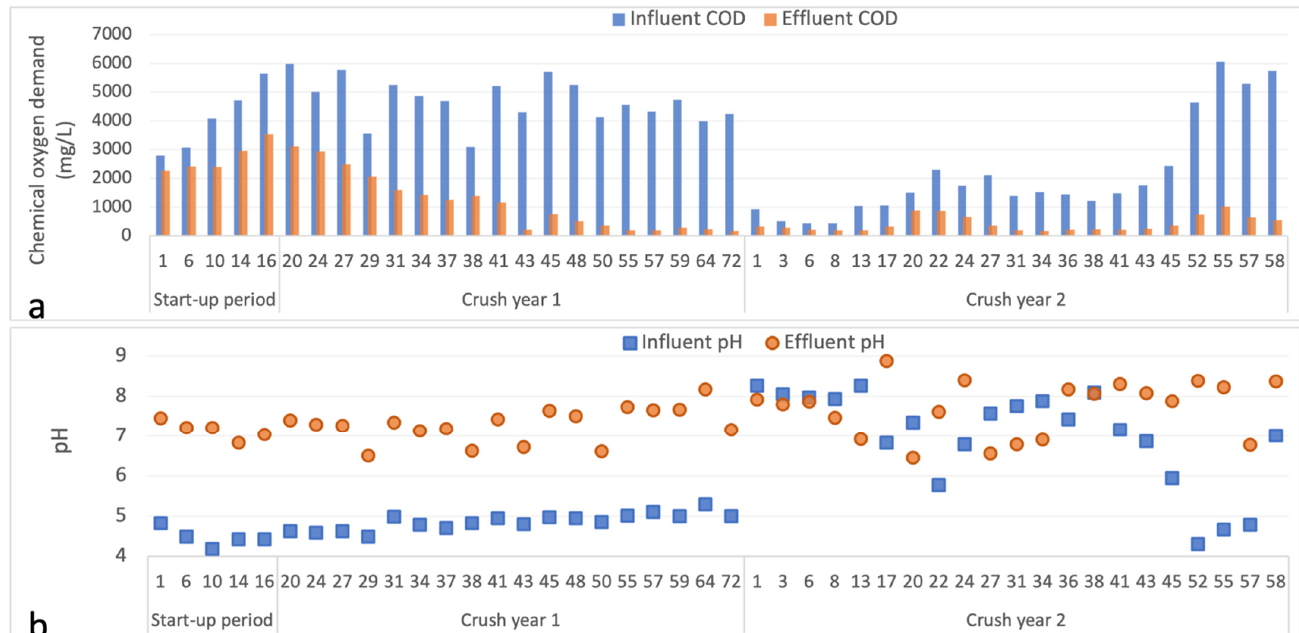
Figure 3. Chemical oxygen demand ( a ) and pH ( b ) measurements from the pilot biological sand reactor system (adapted from [4]).